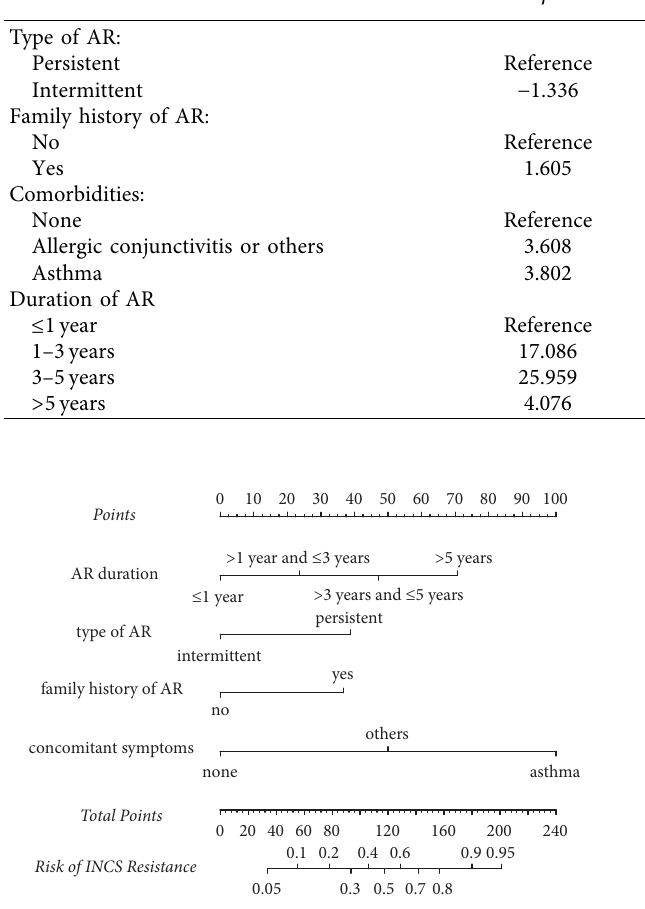
Figure 3: Te development of a nomogram to predict an AR patient’s probability of INCS insensitivity.